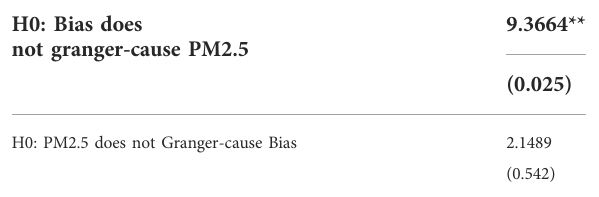
TABLE 7 Endogeneity